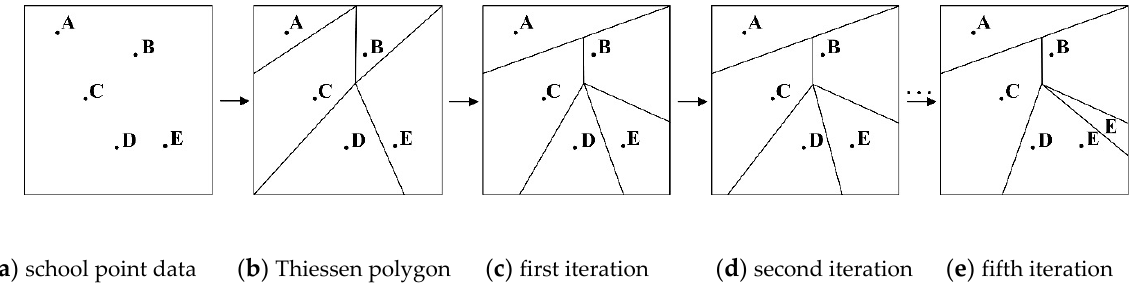
Figure 2. Schematic diagram of the CCDV method for iterative division of school districts.